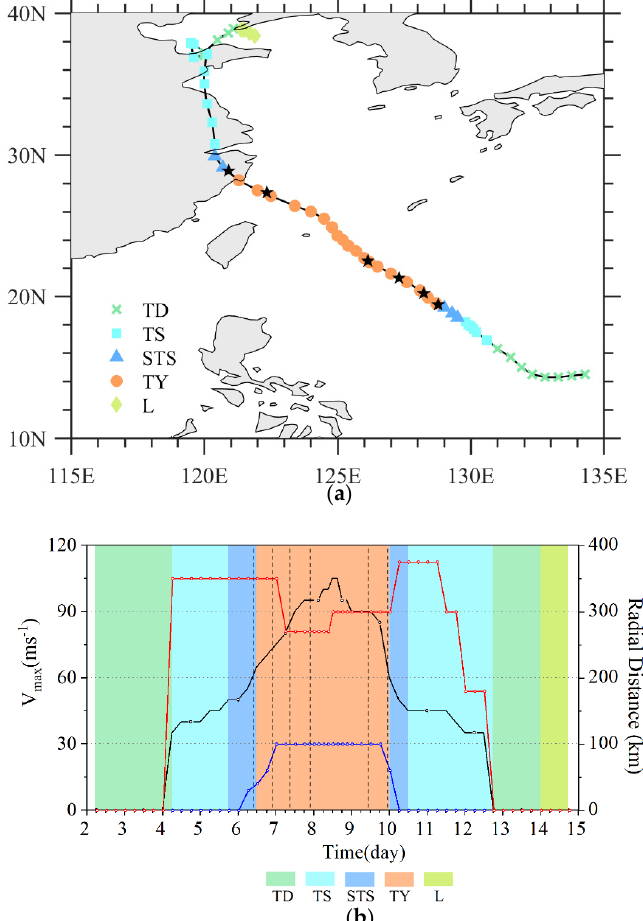
Figure 12. ( a ) The best track and ( b ) the maximum sustained wind (black), the radii of 30-kt (red) and 50-kt (blue) winds for typhoon Lekima during its lifetime from 0600 UTC August 2 to 1800 UTC August 2019. The typhoon category is indicated for tropical depression (TD), tropical storm (TS), severe tropical storm (STS), typhoon (TY), and extra-tropical cyclone (L). The SSMIS observing time along the best track is indicated by stars and dashed lines in ( a , b ),